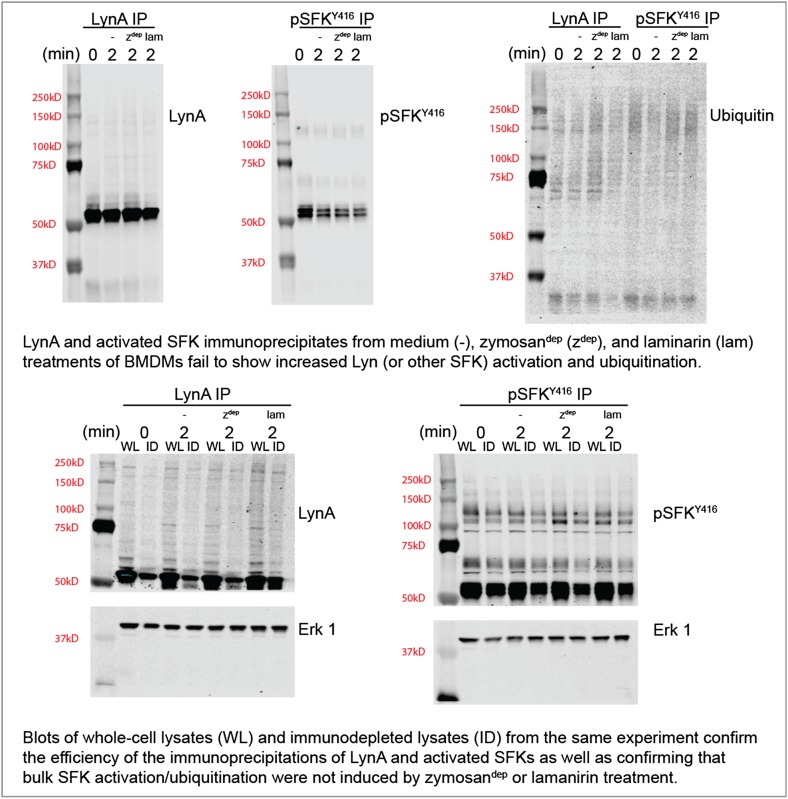
DOI:
http://dx.doi.org/10.7554/eLife.09183.031